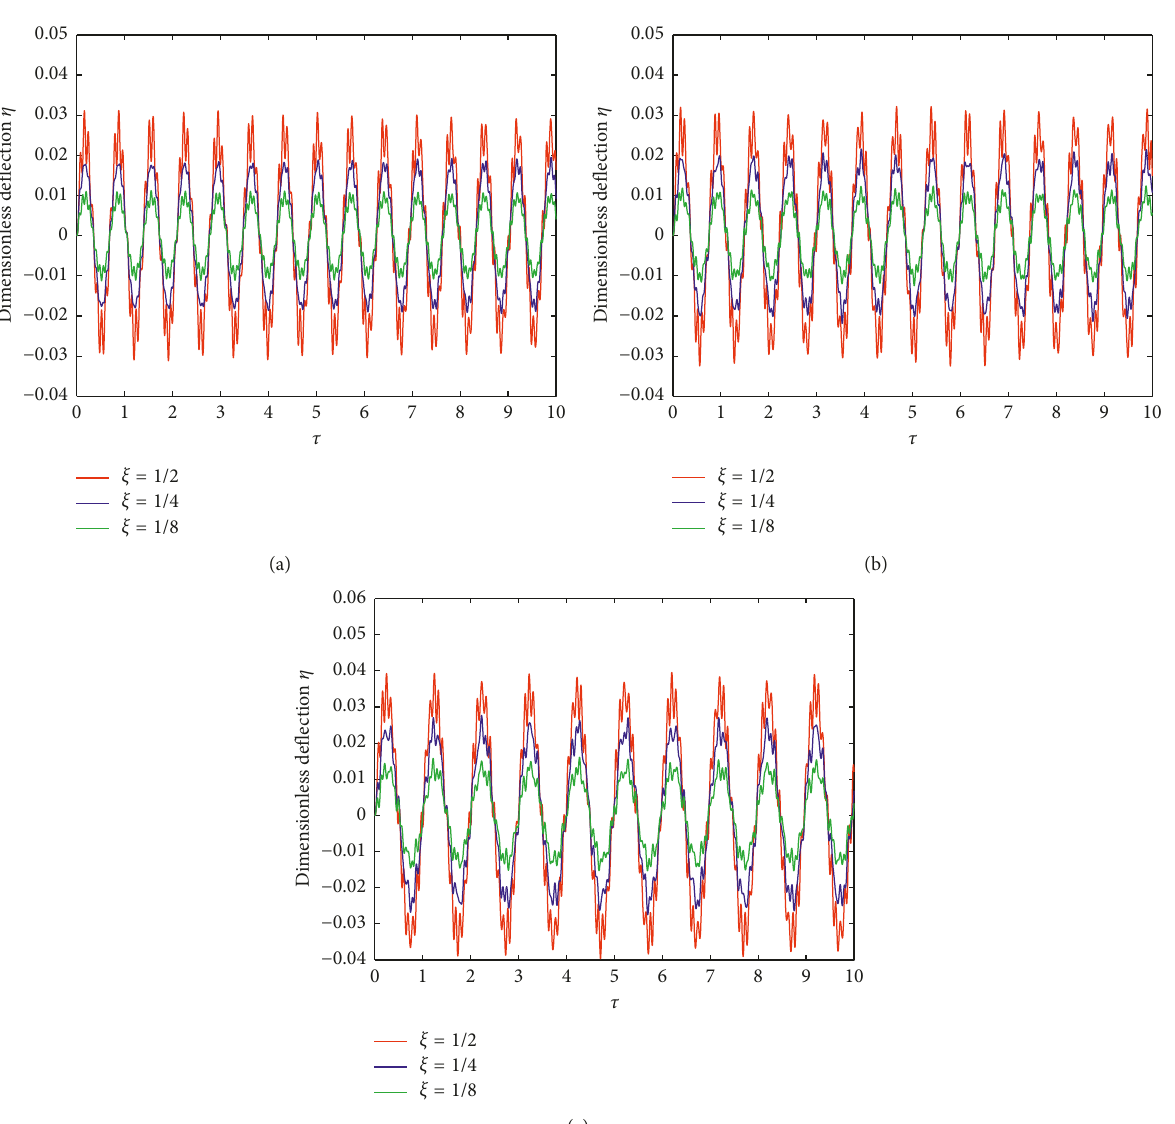
Figure 9: History curves of deflection at different locations on the pinned-pinned pipe having different fluid velocities: (a) u � 0; (b) u � 1; (c) u �